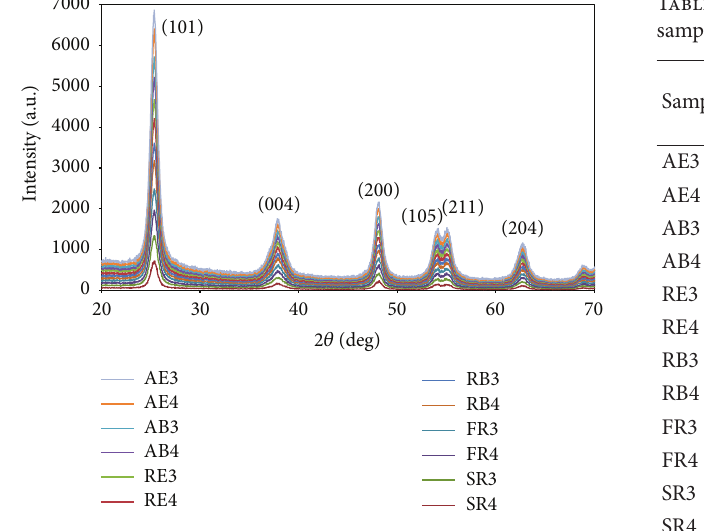
Figure 2: XRD patterns of the prepared mesoporous anatase samples.